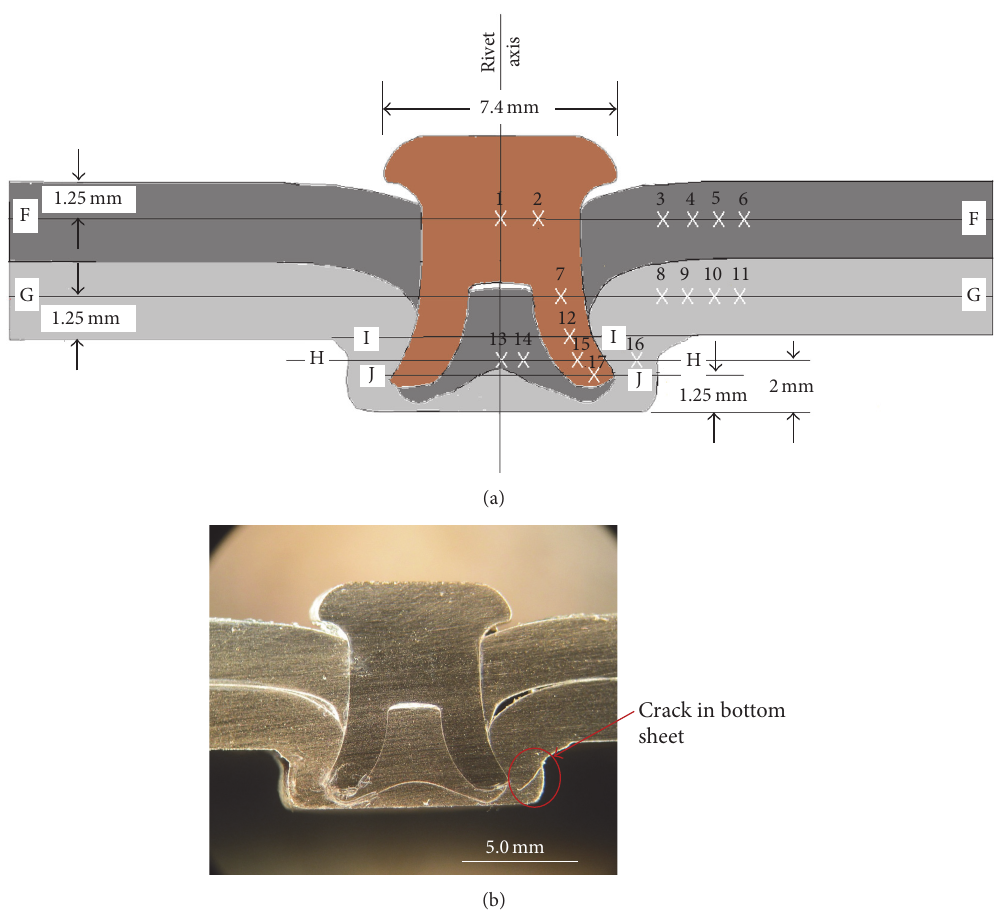
Figure5:(a)JointIIofTable1:(a)residualstressmeasurementlocations;(b)micrographiccross-sectionwhichwassectionedafterconducting neutron diffraction